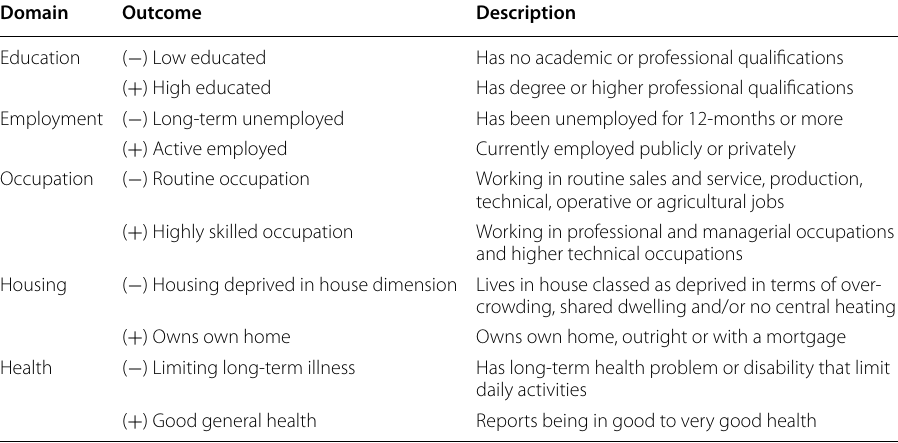
Table 2 Life domains and outcomes of